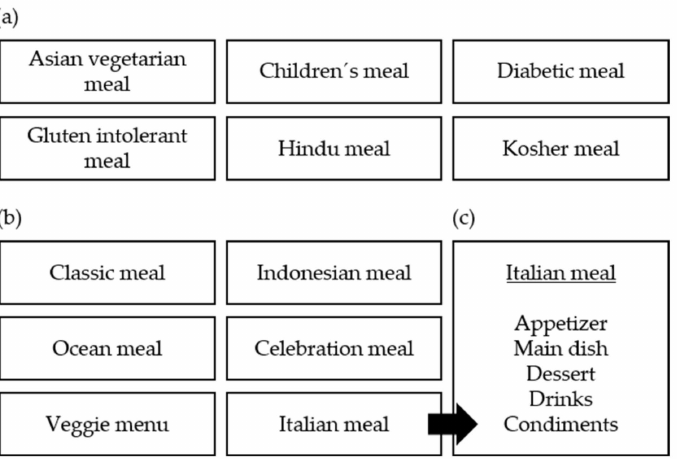
Figure 1. Based on an extract of the pre-ordering options for economy class of an intercontinental flight [15]. ( a ) special meals due to diet, allergies or religious issues (extract), ( b ) further menu options and ( c ) menu